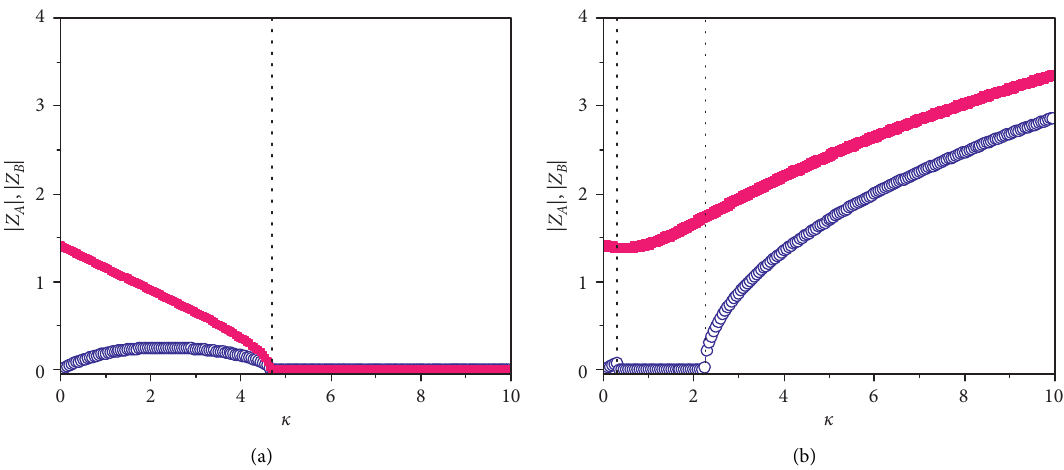
Figure 1: (a) and (b) The average radius | Z the coupling strength κ for δ � 0 . 1 and 0.4, respectively. p � 0 . 8.